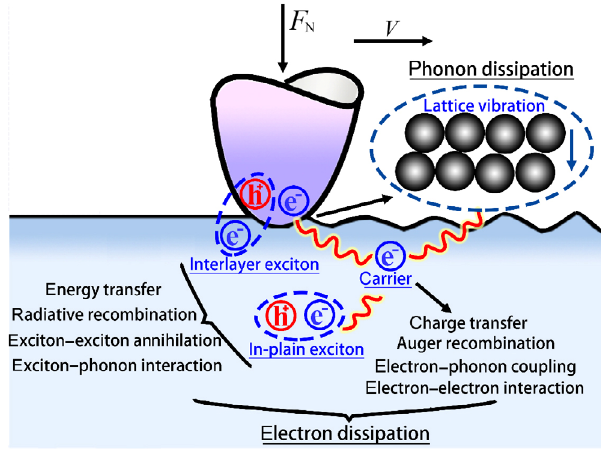
Fig. 8 Schematic of ultrafast friction energy dissipation